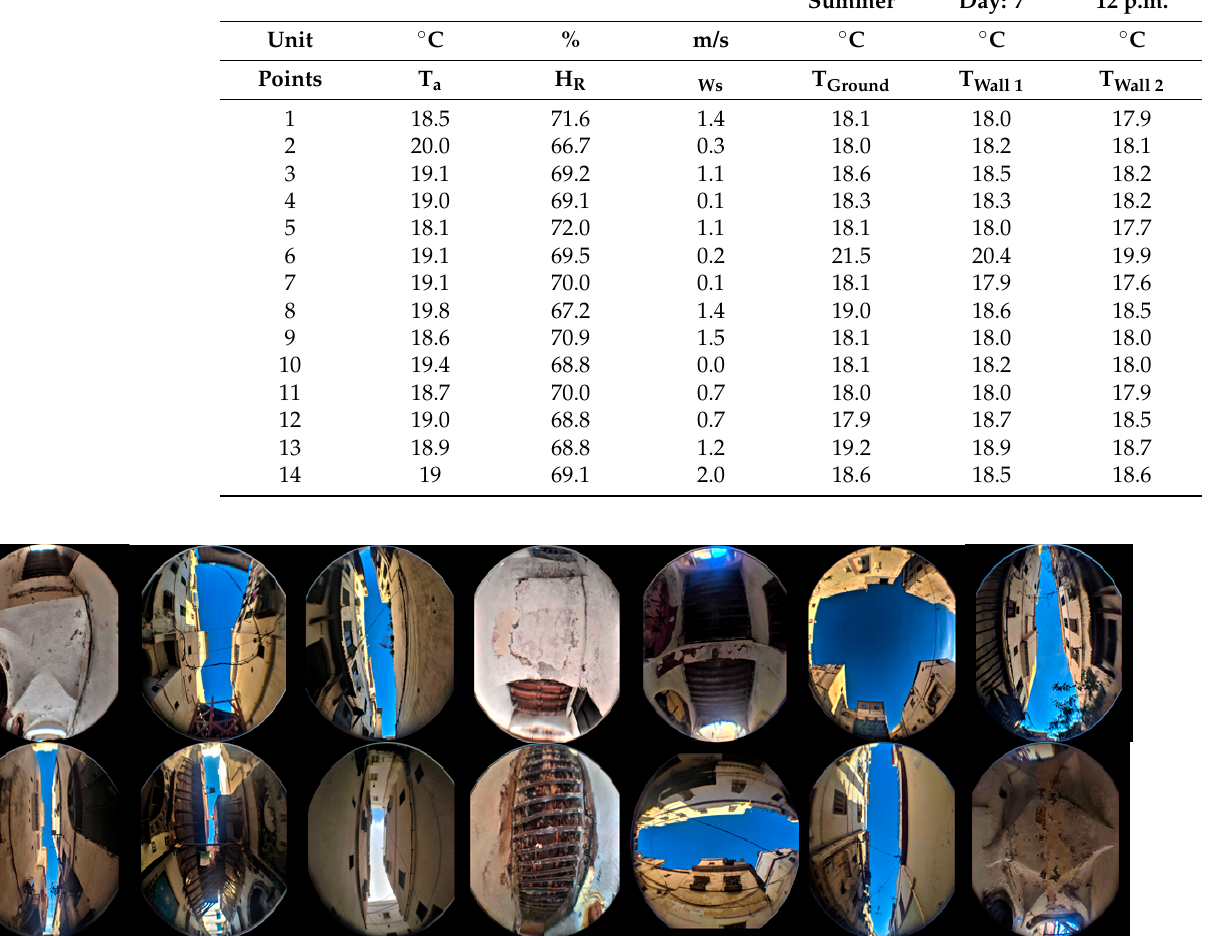
Figure 5. Fisheye images at different measurement points.